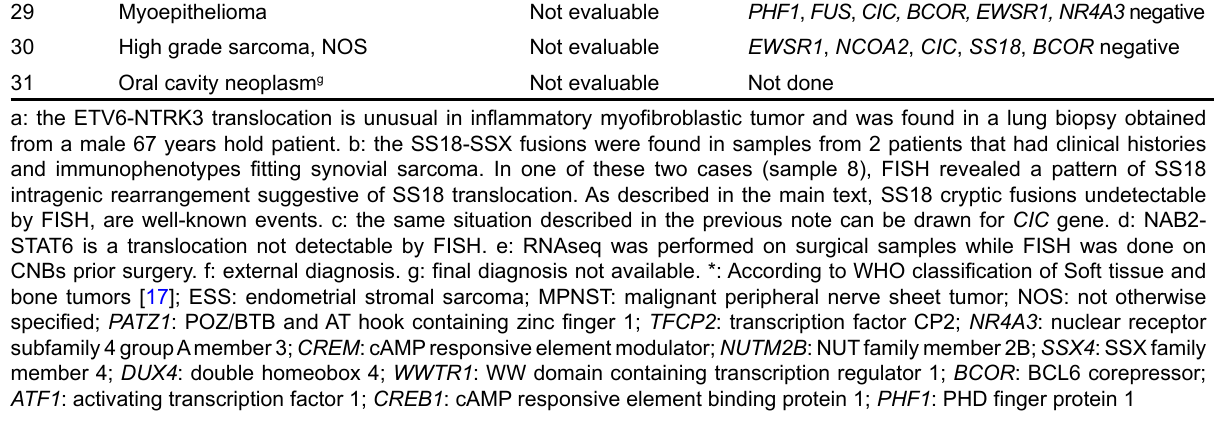
Table 1. Table showing the gene fusions called by ADx in the 31 cases analyzed by sarcoma panel ( continued ) Samples